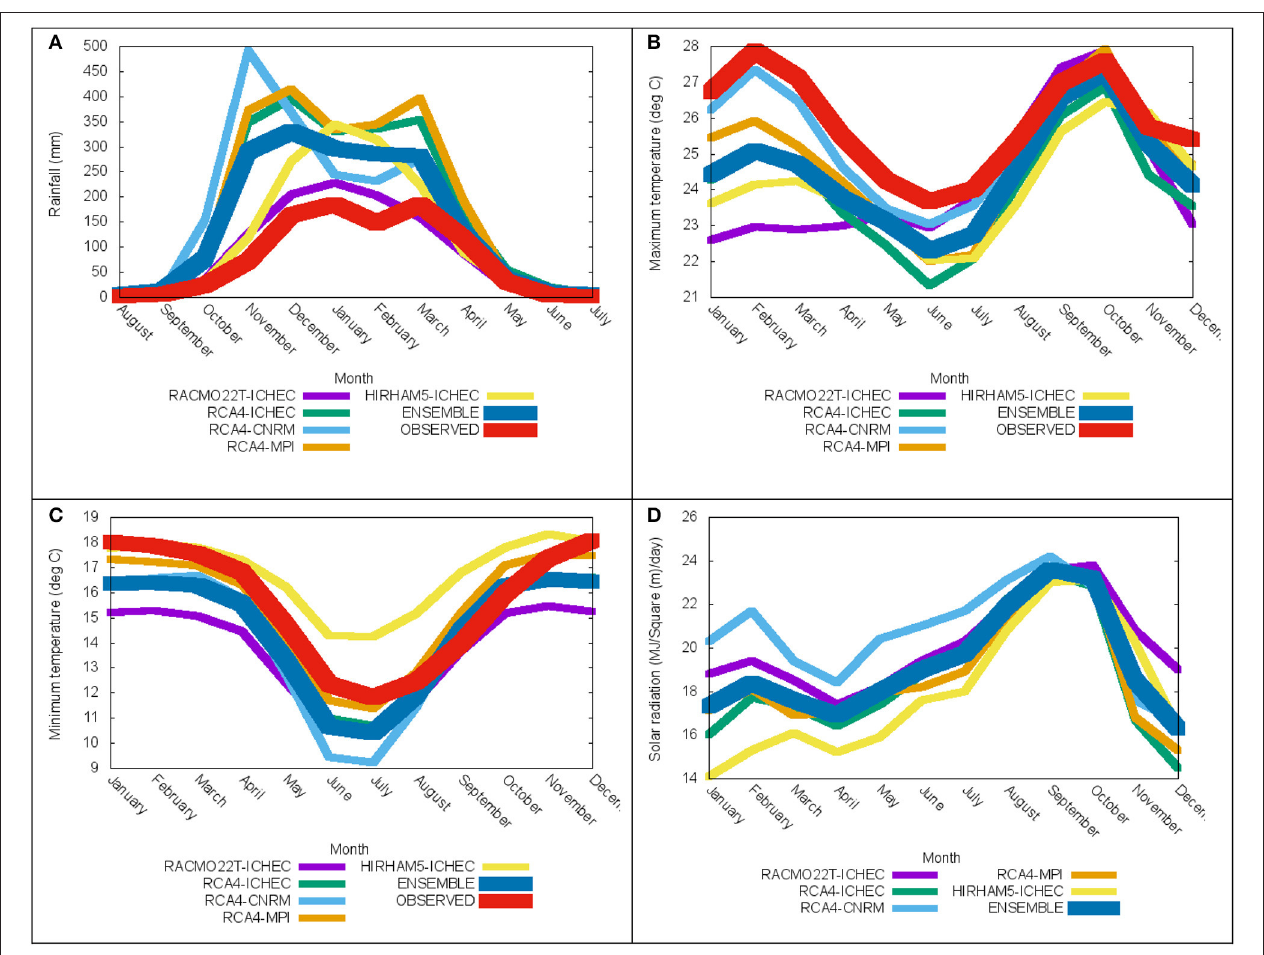
FIGURE 2 | Long-term (1971–2000) annual cycle of climate variables over southern and western highlands sub-agro ecological zones of Tanzania (A) rainfall, (B) maximum temperature, (C) minimum temperature, and (D) Solar radiation.